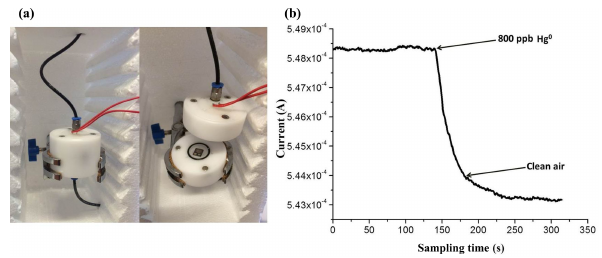
Figure 7. A homemade measurement chamber to house the chemosensor for laboratory experiments (left); a plot depicting the transient response curve to 800ppbHg 0 ( V =